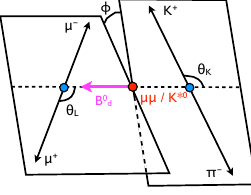
Figure 2. Representation of the B 0 → K ∗ 0 µ + µ − decay showing the definition of the angular observables of the process.